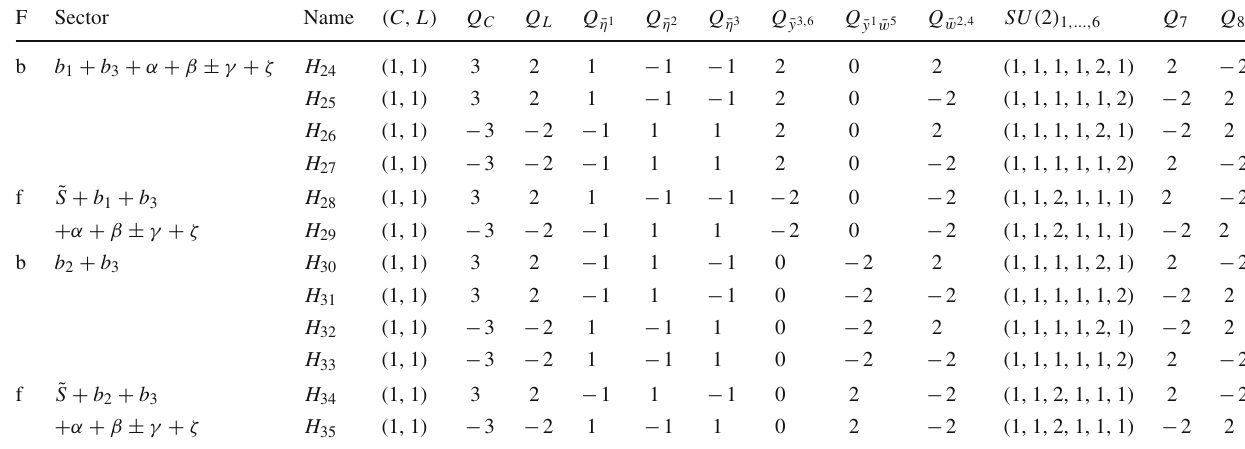
Table 8 Exotic states with ˜ S -partners (ii). All charges are multipled by 4 and the combination ζ = 1 + b 1 + b 2 + b 3 has been used